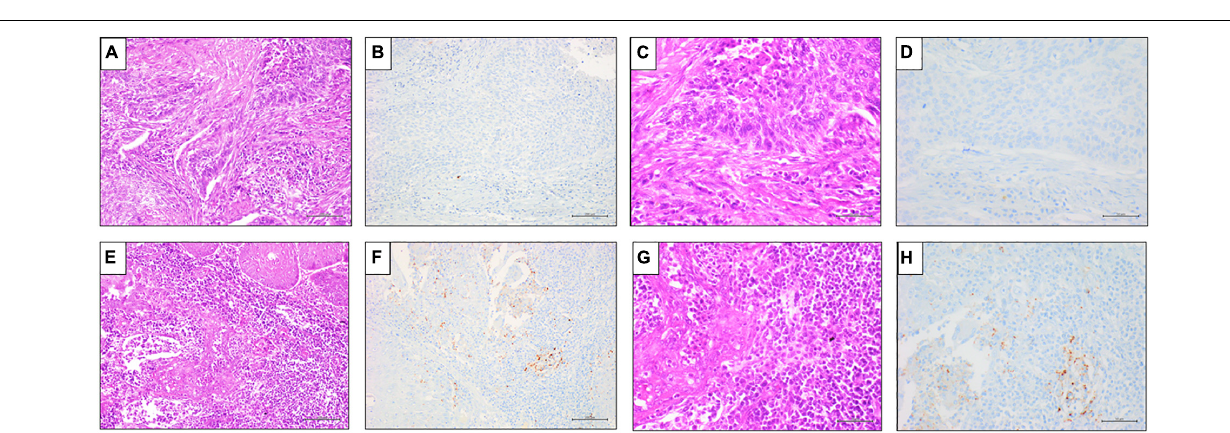
FIGURE 3 | Representative results of PD-L1 SP142 IHC expression in TILs in penile SCC. (A,E) Hematoxylin and Eosin (H&E) staining (20x magnification, scale bar = 100 µ m); (C,G) Hematoxylin and Eosin (H&E) staining (40x magnification, scale bar = 200 µ m); (B,F) negative PD-L1 (clone SP142) IHC expression in TILs, DAB staining (40x magnification, scale bar = 200 µ m); (D,H) positive PD-L1 (clone SP142) IHC expression in TILs, DAB staining (40x magnification, scale bar = 200 µ